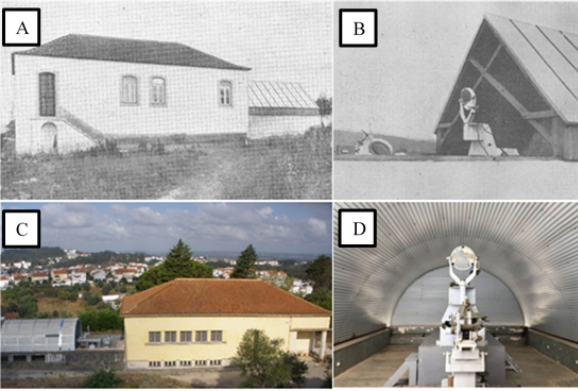
Figure 6. The spectroheliograph pavilion (A) and the coelostat (B) in 1926 [Source: Lobo (1932)]. The building where solar observations are currently made (C) and the coelostat, at the COI campus (D).